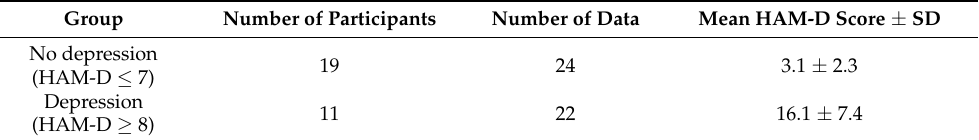
Table 4. Average value of Hamilton Rating Scale for Depression (HAM-D) score for each group. Group Number of Participants Number of Data Mean HAM-D Score ± SD No depression (HAM-D ≤